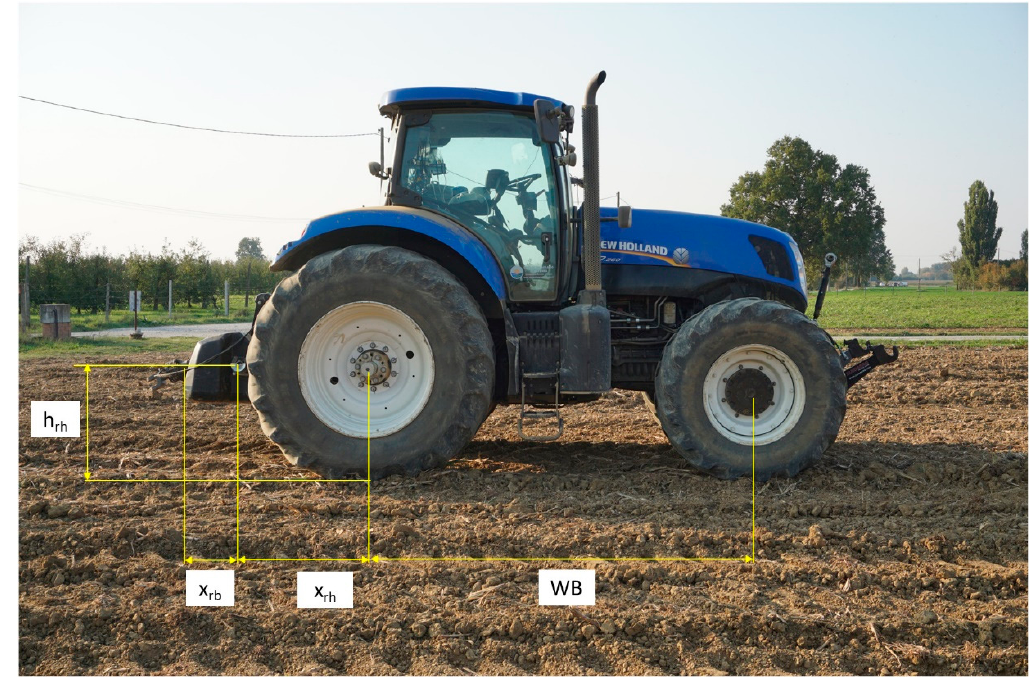
Figure A2. Tractor dimensions in R configurations.